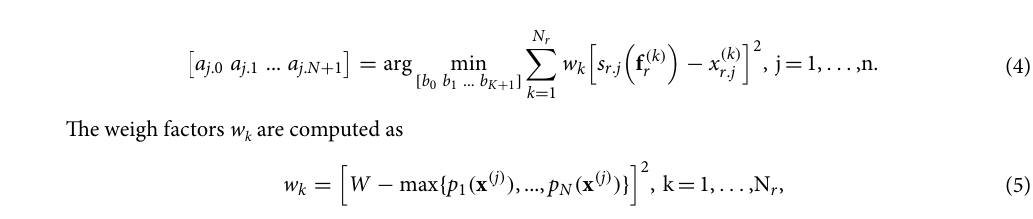
Figure 3. Inverse regression model s r constructed based on the pre-selected trial points x r ( j ) along with their respective objectives f r ( j ) . The model elements s r.j are are shown as grey surfaces for the parameters x 1 (left), x 2 (middle), and x 3 (right),